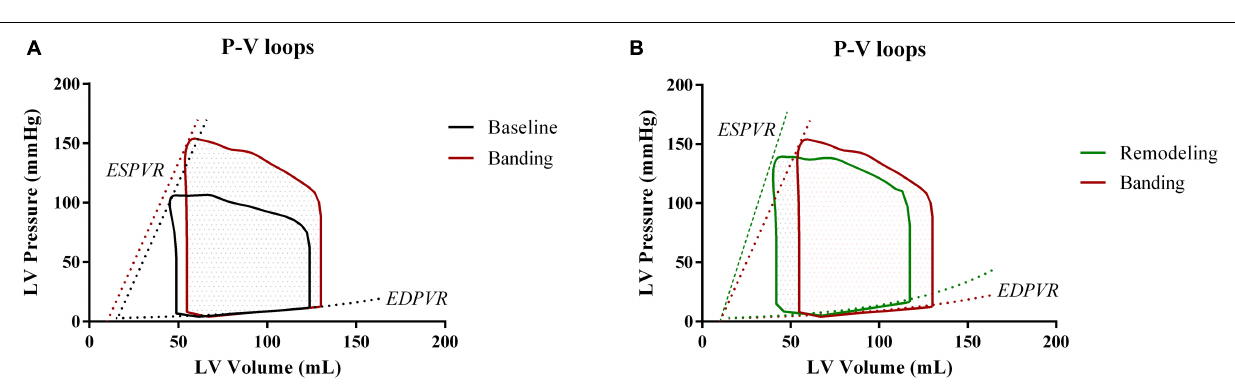
FIGURE 3 | Comparison of the pressure-volume loops at the three different phases. (A) Baseline versus acutely after banding. (B) Acutely after banding versus after LV remodeling under the form of concentric